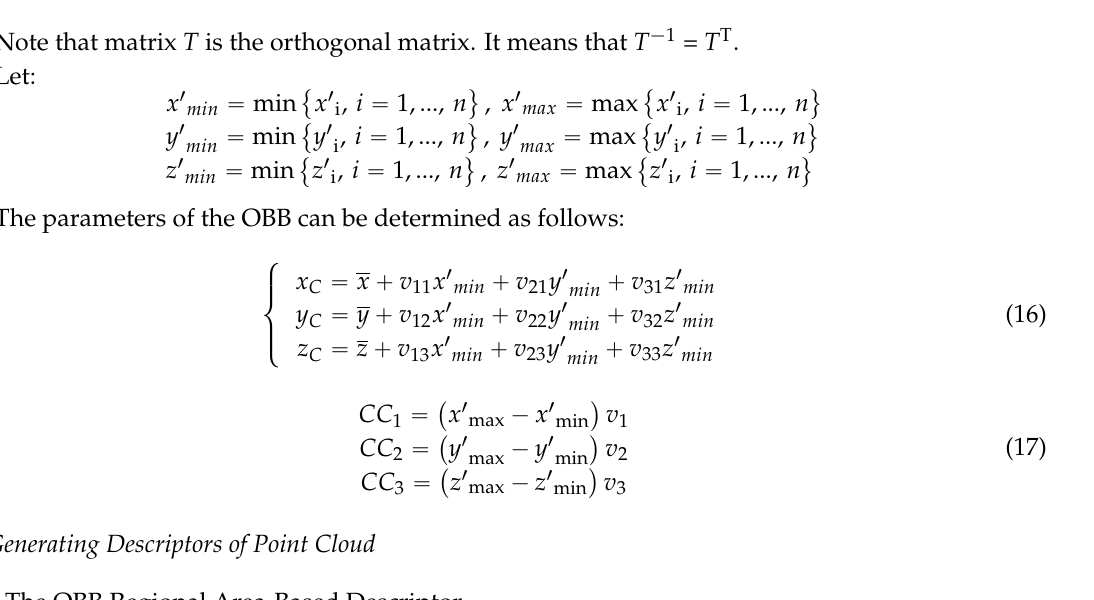
Figure 6. The coordinates of point p i (green dot) in the absolute and relative coordinate systems.